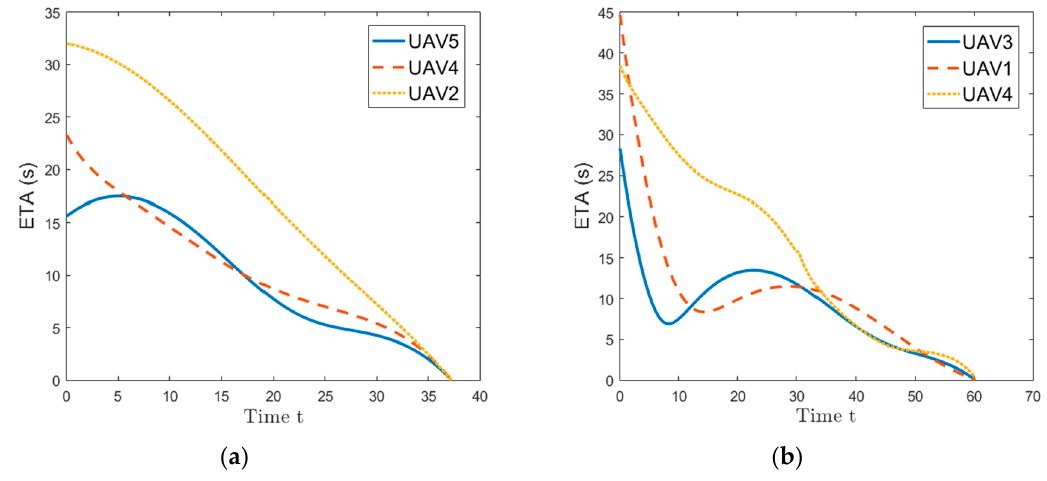
Figure 3. ( a ) The ETA for the target T 1 ; ( b ) the ETA for the target T 2